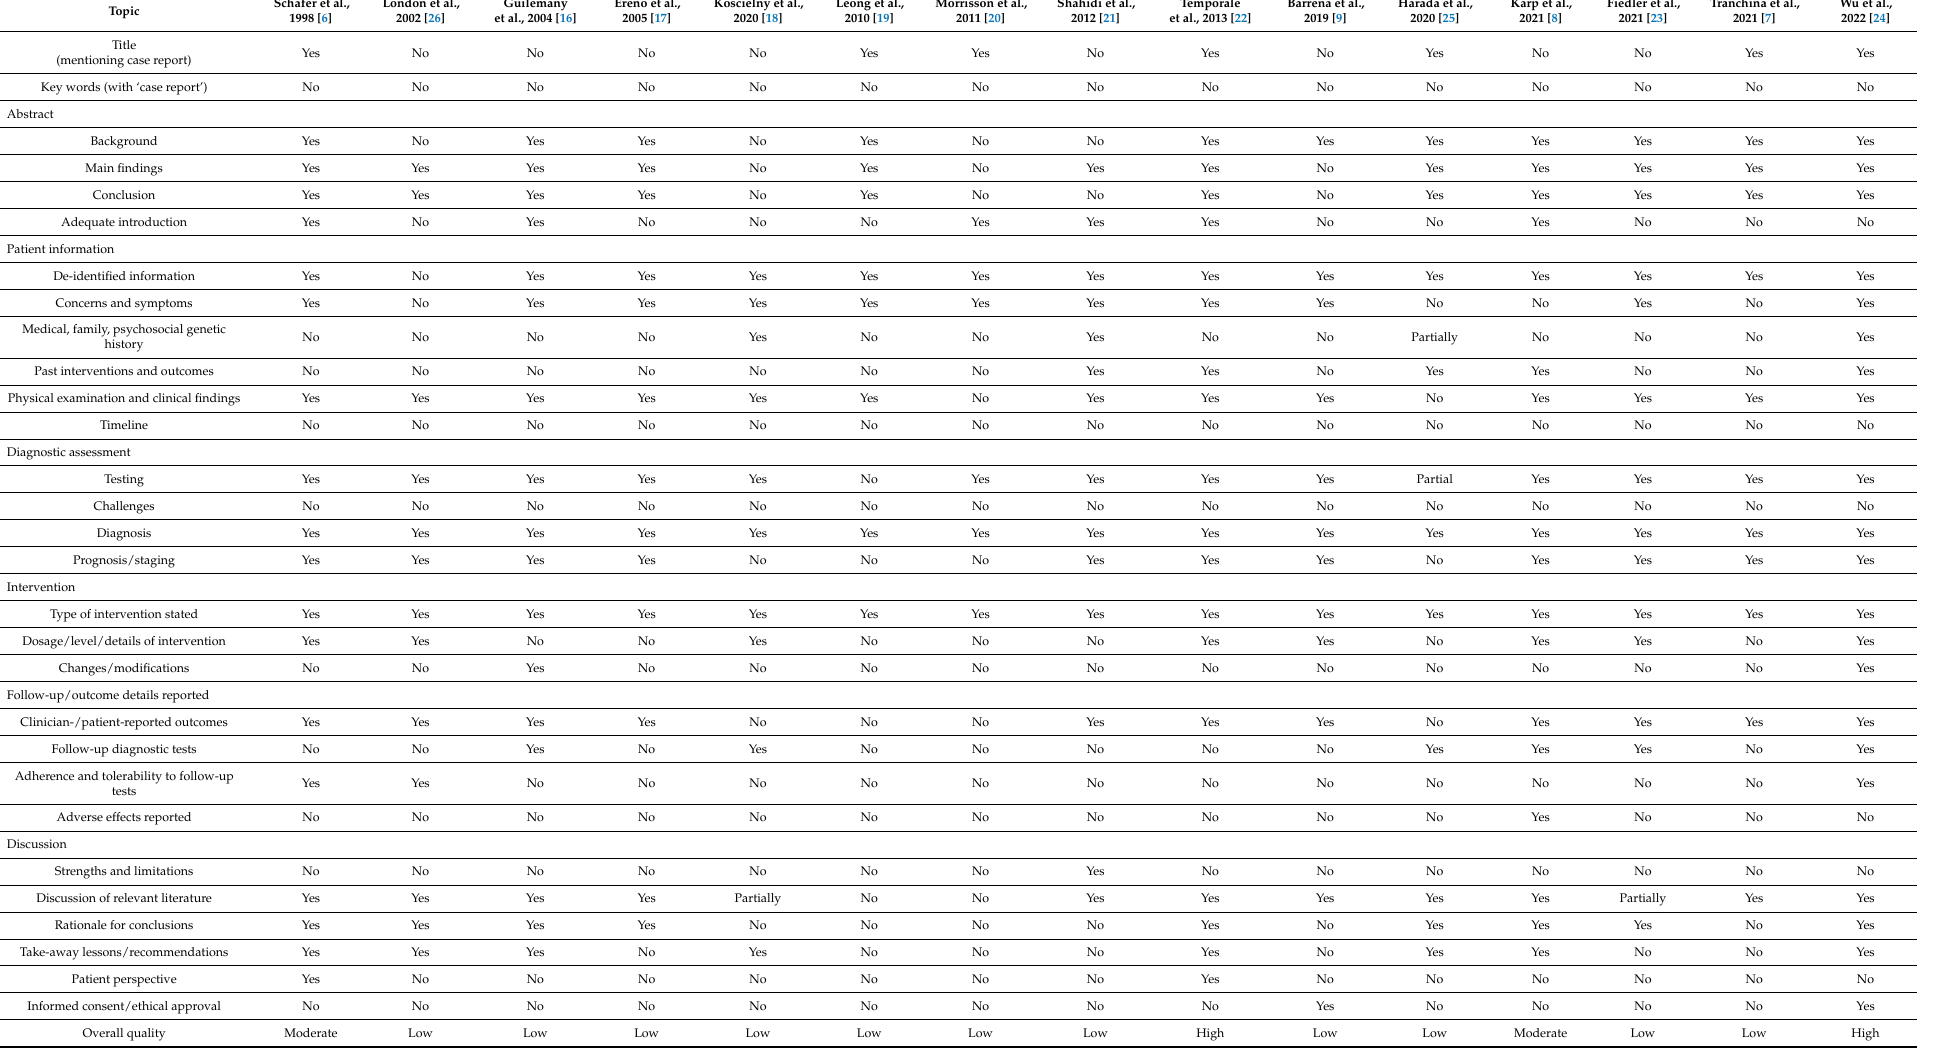
Table 3. The results of the quality assessment of the included studies using the CARE guidelines